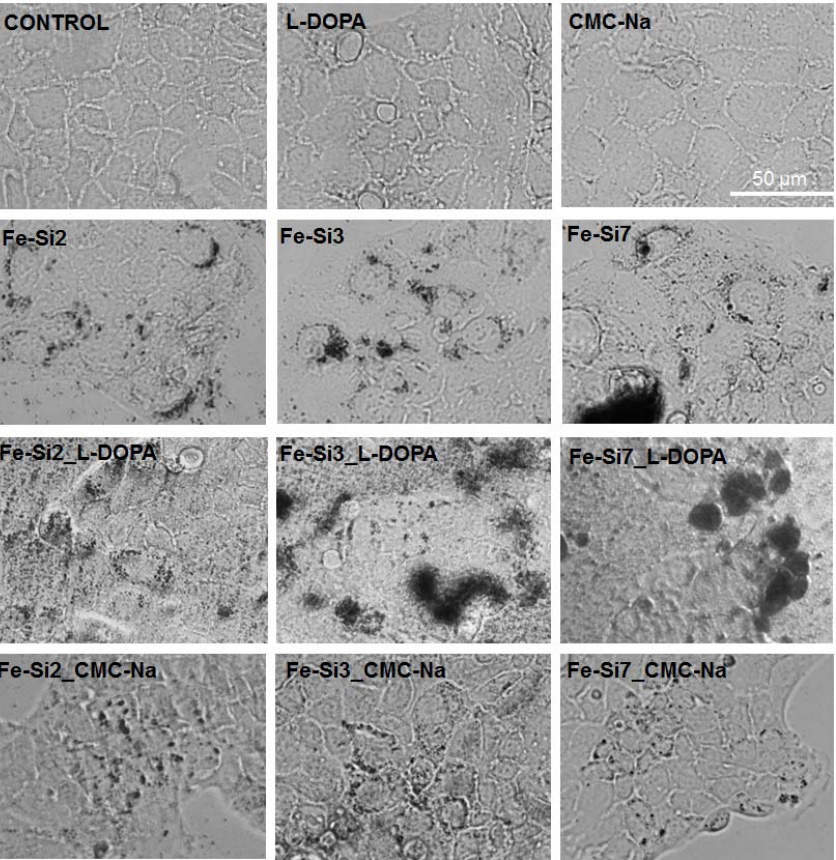
Figure 9. Images representing Caco2 cell morphology after exposure for 72 h to 50 µg/mL hybrid Fe-Si NPs. Bright-field images showing NP dispersion and internalization into the cells. Data are representative of 3 separate experiments with 3 replicates for each experimental condition. Control represents untreated cells. Scale bar = 50 µm.